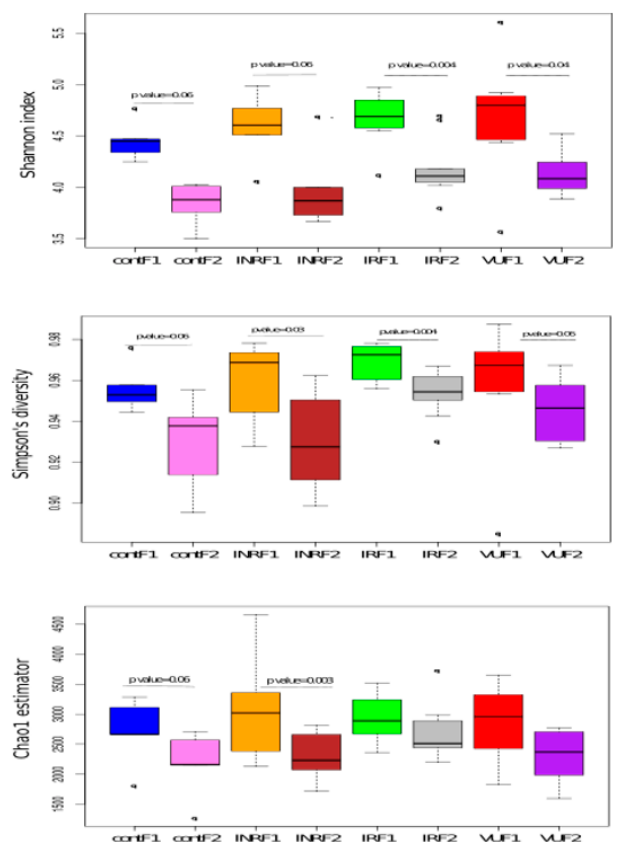
Figure 4. Alpha diversity before and after prebiotic intervention. Shannon diversity index, Simpson’s index of diversity, and Chao1 richness estimator in the four groups. To calculate differences between groups, we used the Wilcoxon rank-sum test ( p -value = 0.05). F1, at baseline; F2, after prebiotics. INR, immunological ART non-responders; IR, immunological ART responders; VU, viremic untreated; cont, controls.